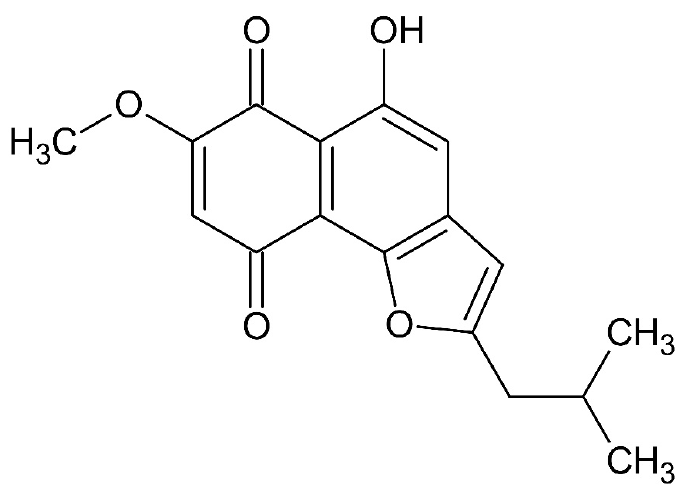
Figure 1. Chemical structure of rinderol.